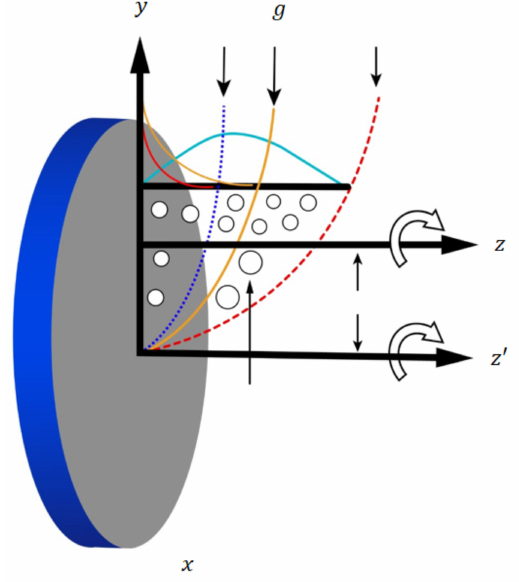
Figure 1. Geometry of the developed